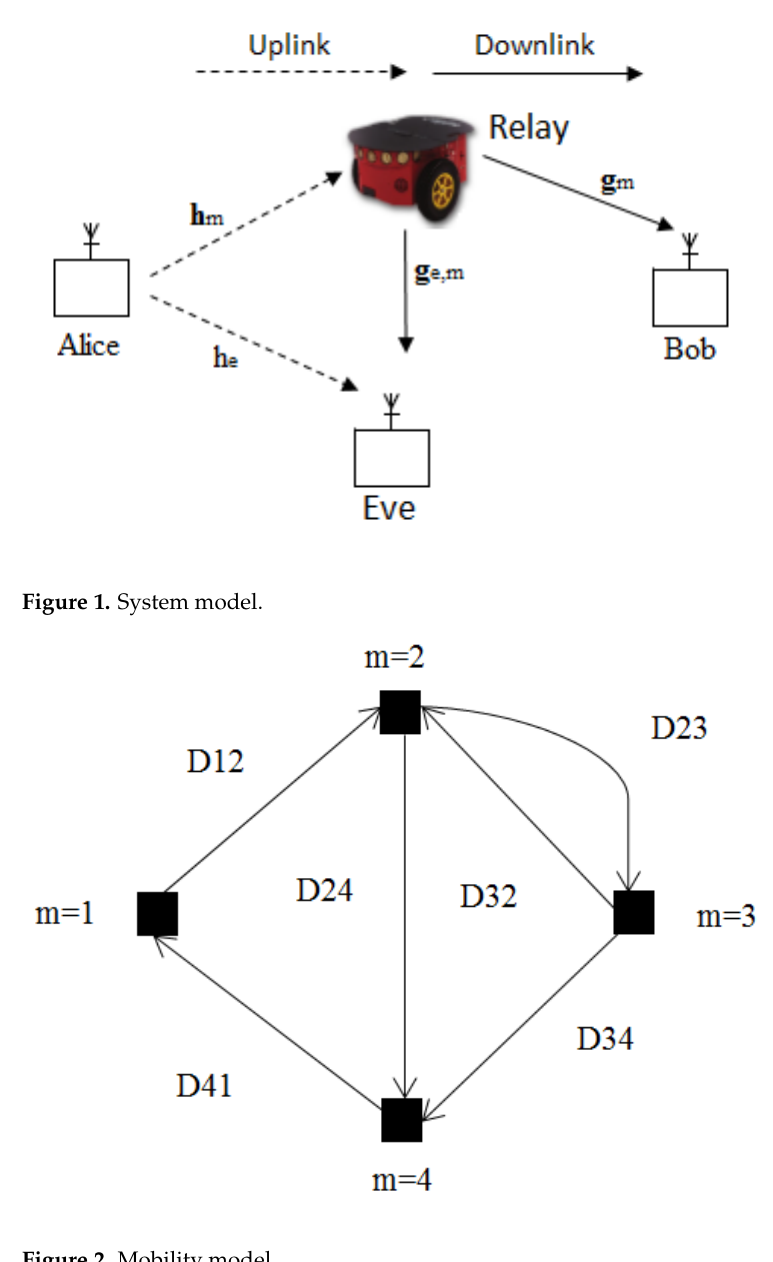
Figure 2. Mobility